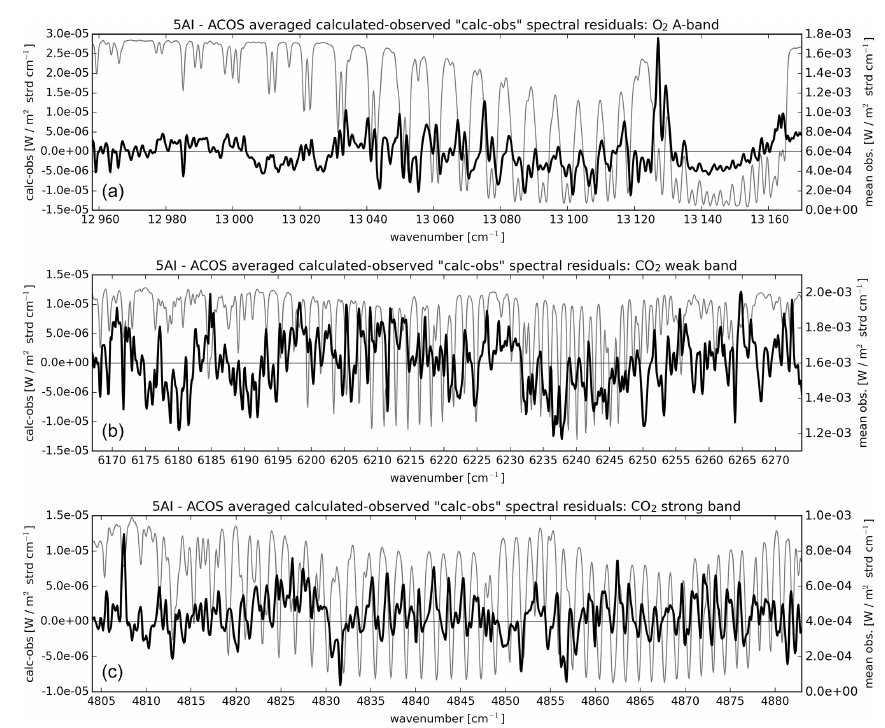
Figure 11. 5AI–ACOS average calc–obs spectral residuals in the O 2 A band (a) , CO 2 weak band (b) , and CO 2 strong band (c) appear in thick black lines (left axis). A typical spectrum for the three bands is shown in thin grey lines (right axis).